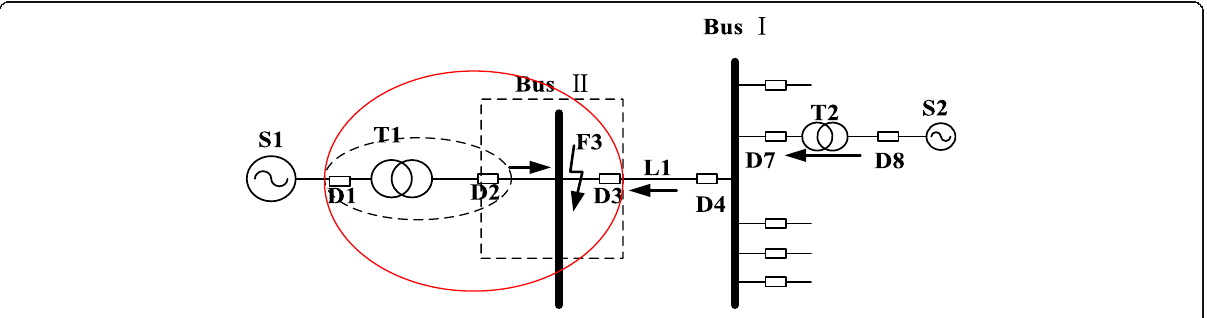
Fig. 7.1 L1 is not included in EBDP II within 100 ms of the fault in F3